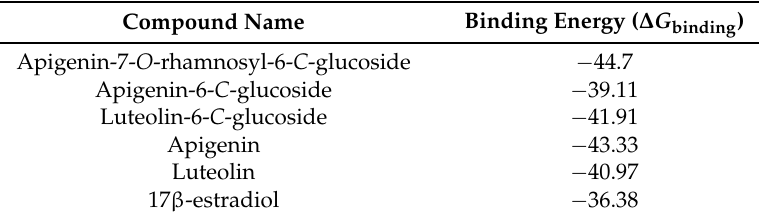
Table 1. The computed binding energy values ( ∆ G binding ) for the molecular docking study for the binding of the isolated components in Erythrina crista-galli extract with human Estrogen Receptor R